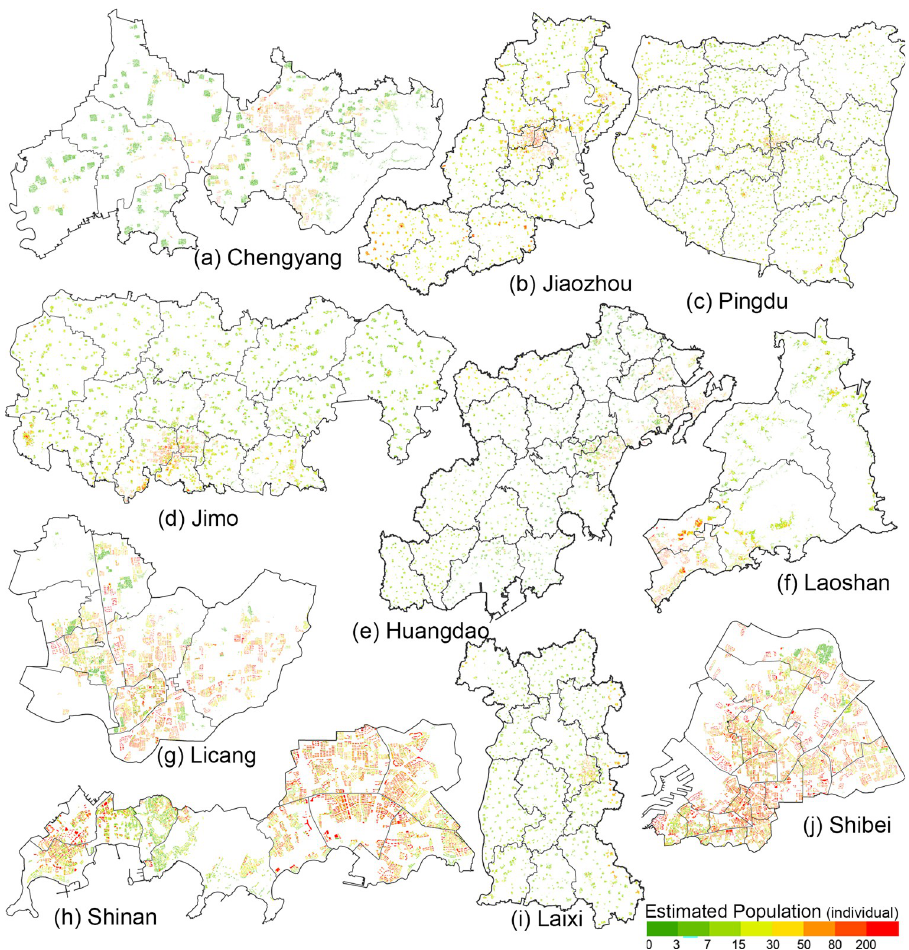
Fig 8. Resident population in Qingdao in